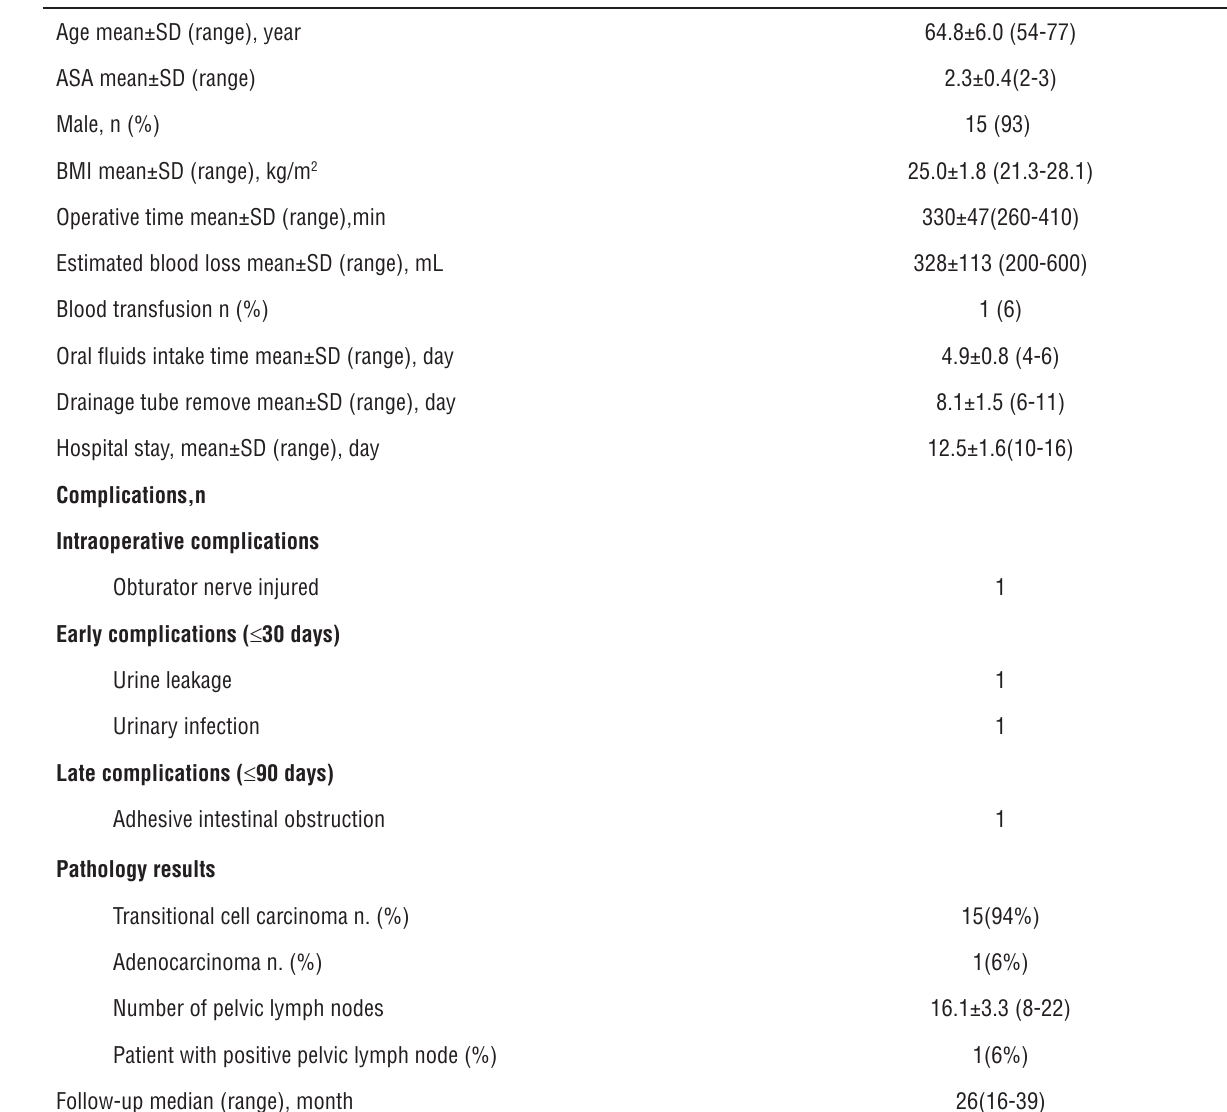
Table 1 - Demographics and surgical